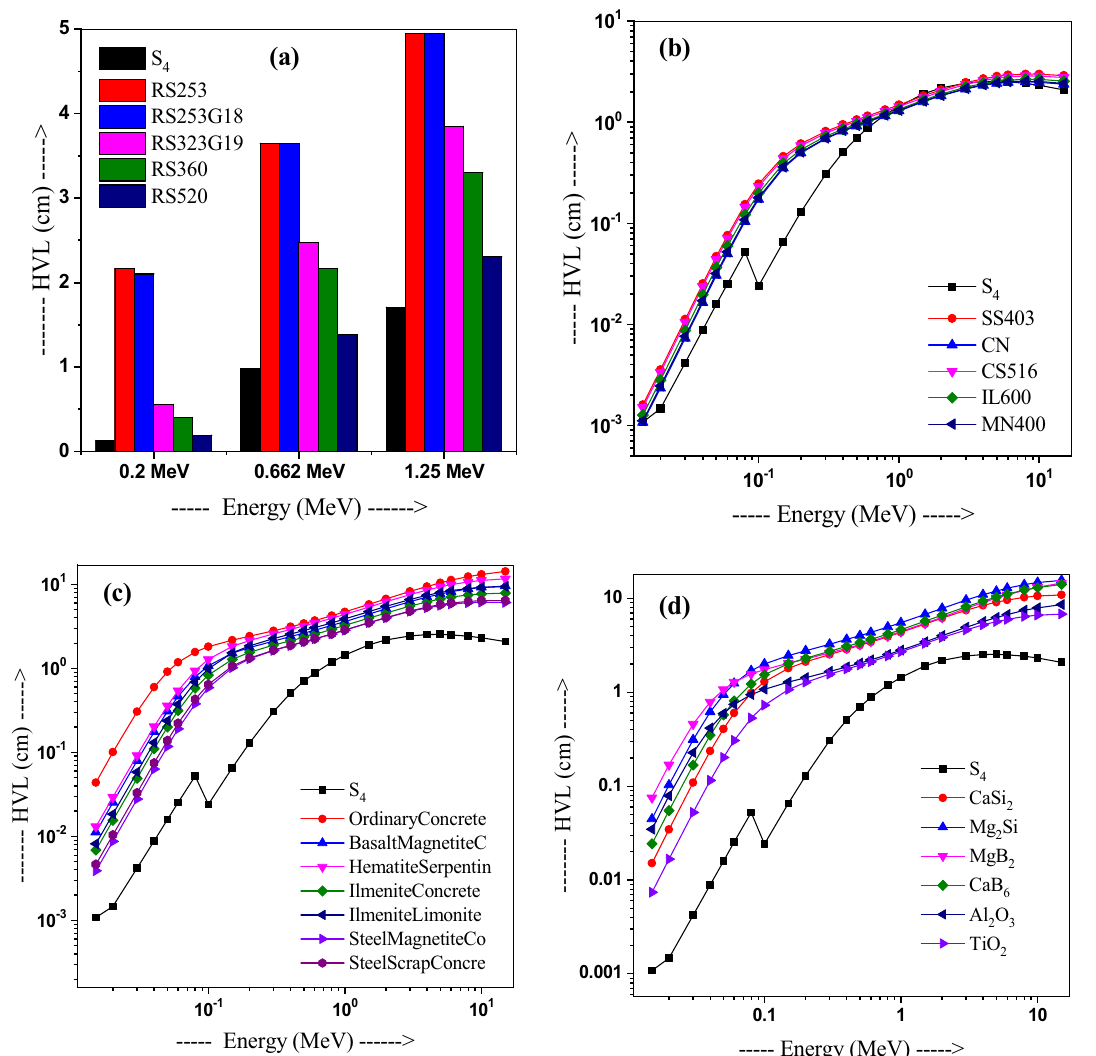
Figure 8. Comparison of HVL values of glass S4 with those in ( a ) commercial shielding glasses, ( b ) alloys, ( b ) alloys, ( c ) concretes and lead, and ( d ) ceramics